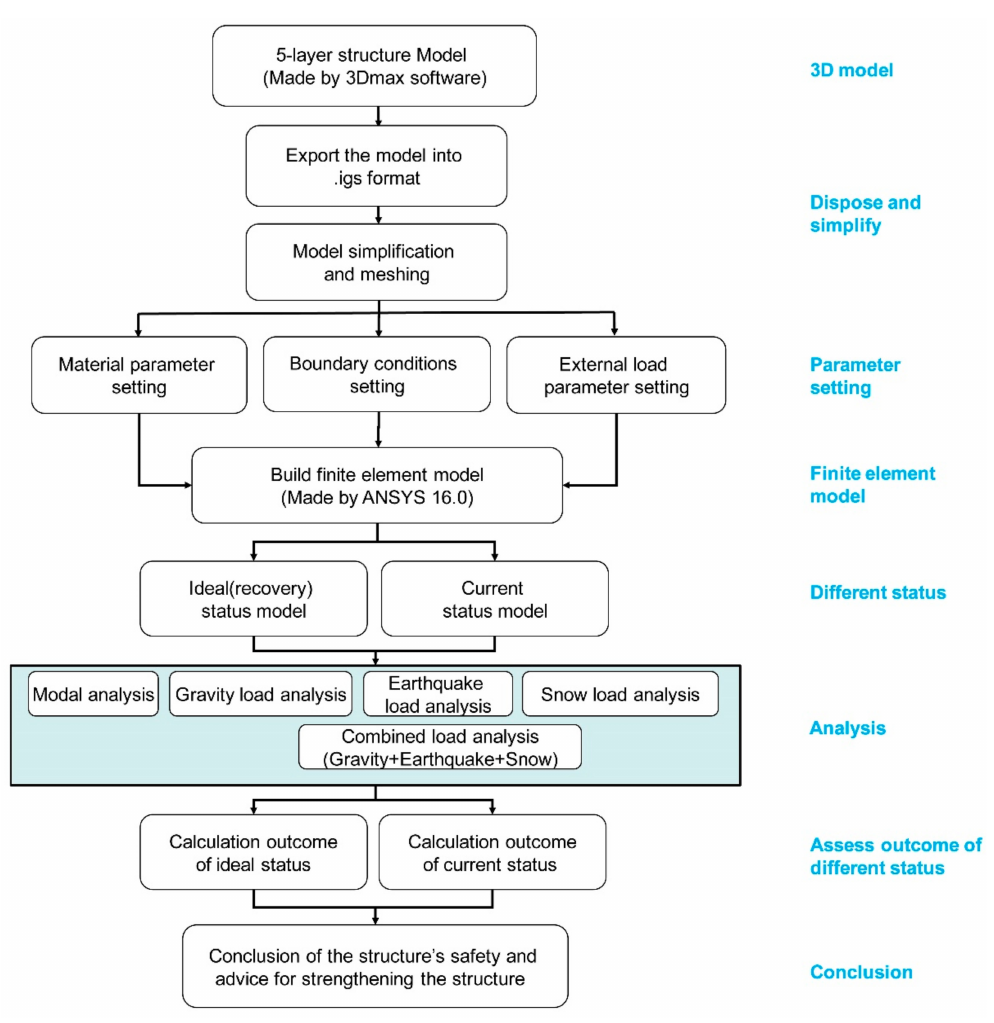
Figure 13. Finite element modeling and earthquake resistance analysis process diagram of architectural heritage with multilayer